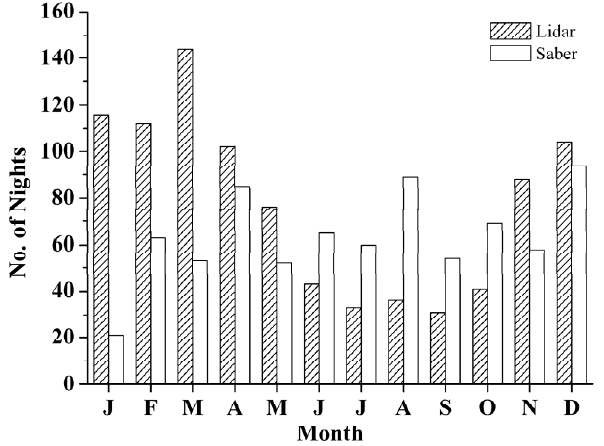
Fig.2. Total number of observation nights for lidar (1998-2008) and SABER (2002-2008). Fig. 2. Total number of observation nights for lidar (1998–2008) and SABER (2002–2008).